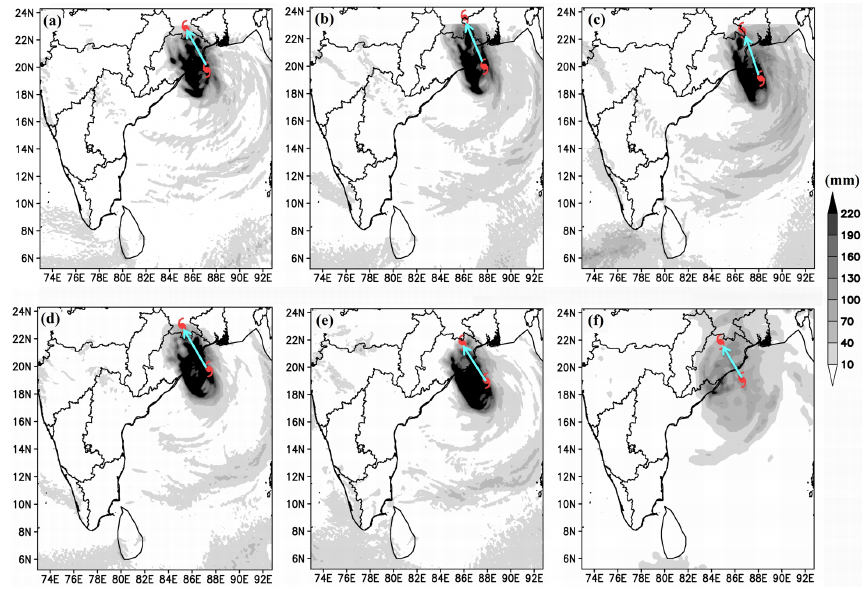
Figure 14. Comparison of simulated cumulative 24h rainfall for Phailin on 12 October 2013 from (a) CTL, (b) VARAMV, (c) VARRAD, (d) VARPREP, (e) VARPREP + RAD and (f) TRMM observation. The cyclone symbols in red indicates the initial and final position of the cyclone during this day (from 00:00UTC 12 October to 00:00UTC 13 October 2013) and the arrow (sky blue) shows the direction of movement of the